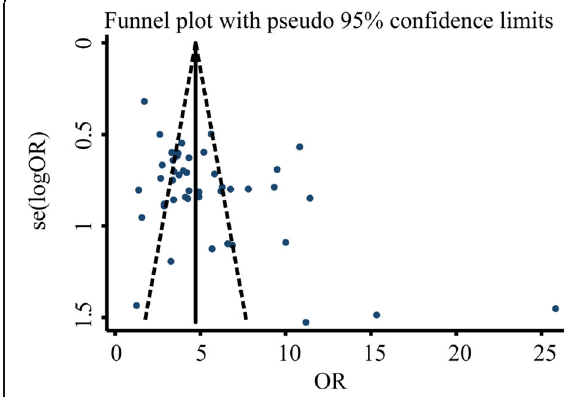
Fig. 9 Inverted funnel plots of bias analysis on adverse reaction rates